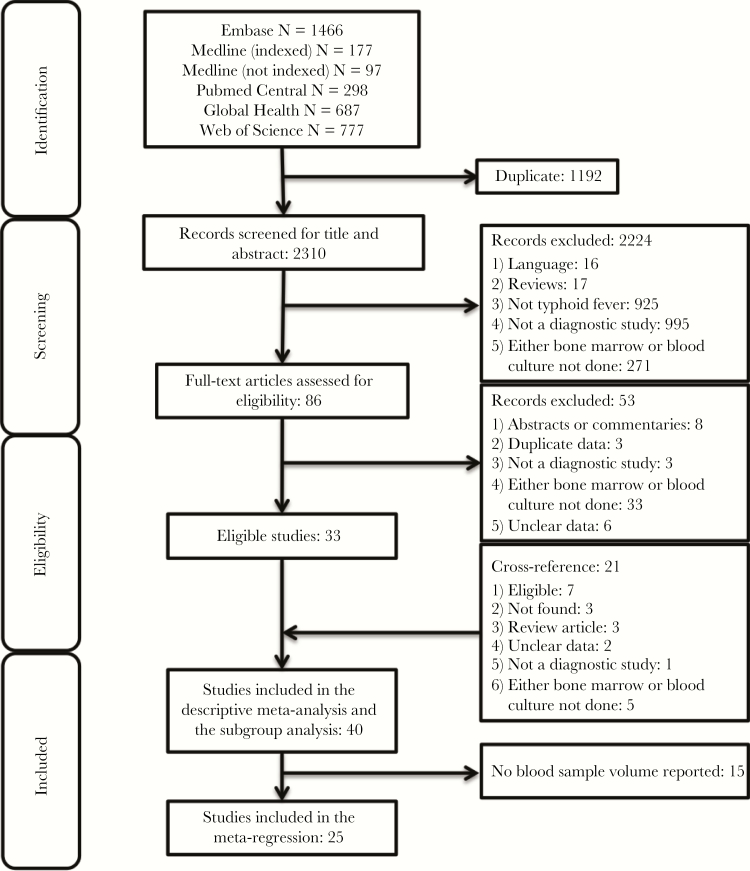
Preferred Reporting Items for Systematic Reviews and Meta-Analyses (PRISMA) diagram for systematic review. A systematic search in 6 databases yielded 3502 articles, or 2310 unique articles, 86 of which were eligible for full-text review. A total of 40 studies were included in the descriptive synthesis, and 25 studies had blood volume information and were included in our meta-regression analysis of the relationship between blood sample volume and blood culture sensitivity.